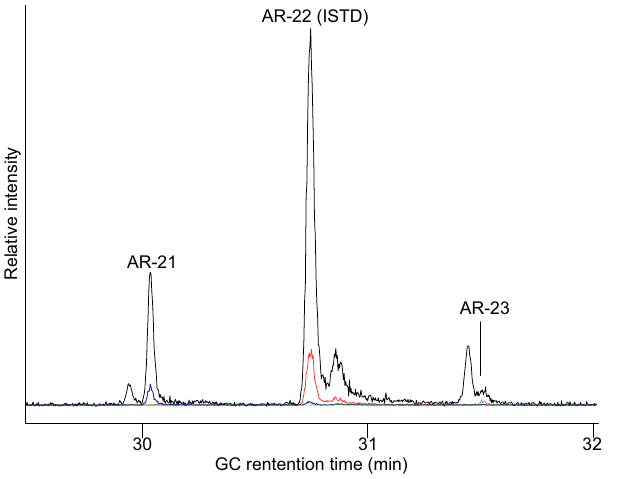
Fig.4|PartialGC-QToFMSExtractedIonChromatogramsshowingtheelution of alkylresorcinols in extract LAN16-33. Drawn in black is the Extracted Ion Chromatogram of m/z 268.1315, the base peak in spectra of trimethylsilylated alkylresorcinols (AR). Drawn in blue, red, and green are Extracted Ion Chromato- grams of m/z 548.4445, m/z 562.4602 and m/z 576.4833, which are the molecular ions of AR-21, the internal standard AR-22 (ISTD, added at level of 50ng/g to samples)andAR-23,respectively.Bothionsincombinationwiththeretentiontime allow the unambiguous identi fi cation of the alkylresorcinol homologues.